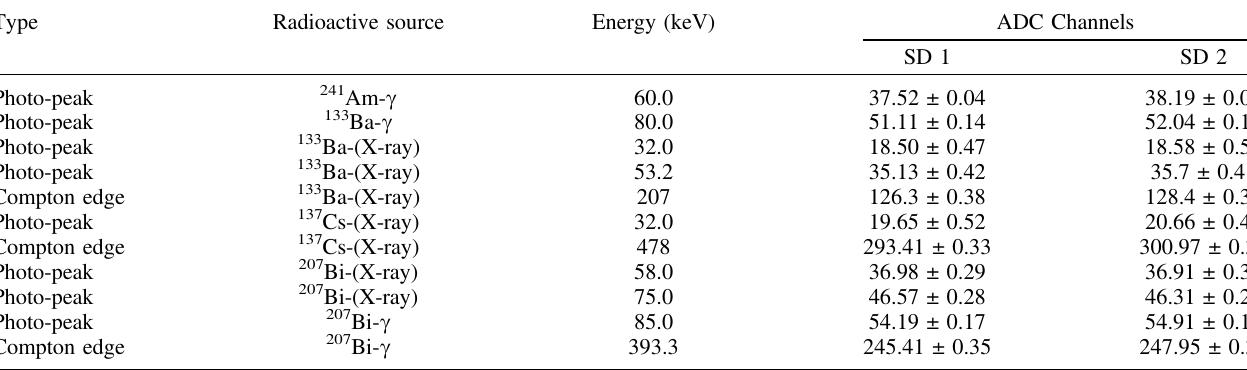
Table A.1. Calibration values and statistical comparisons for both